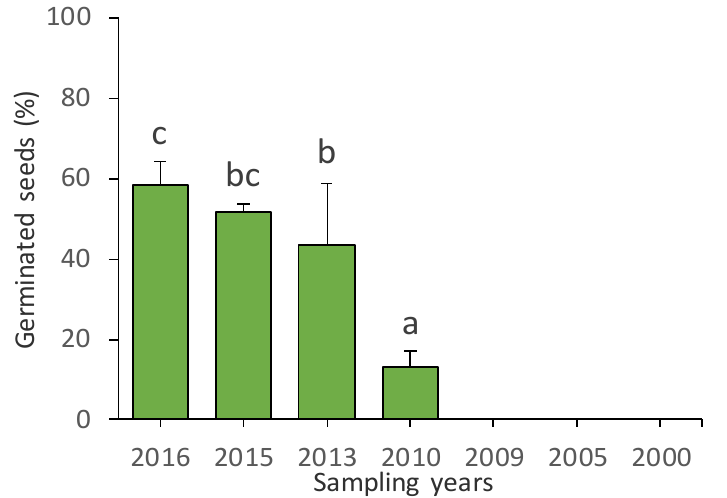
Fig. 1. Effect of the indicated pre-treatments on seed germination kinetics and germination percentages for Thalictrum maritimum seeds sampled in 2016 (A) and 2015 (B)